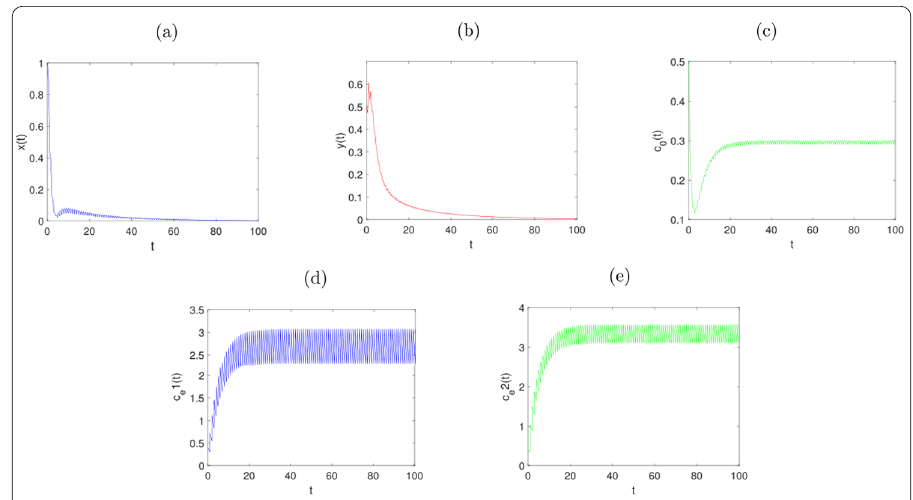
Figure 2 Globally asymptotically stable population-extinction periodic solution of system (2.1) with x ( t ) = 1, y ( t ) = 0.5, c o ( t ) = 0.5, c e 1 ( t ) = 0.4, c 1 = 0.1, d 1 = 0.1, β 1 = 0.01, d 2 = 0.3, β 2 = 0.01, f = 0.1, g = 0.4, m = 0.5, h 1 = 0.3, h 2 = 0.15, a = 0.4, b = 1, c 2 = 0.5, d 3 = 0.1, E 1 = 0.3, d 4 = 0.1, E 2 = 0.05, u 1 = 0.01, u 2 = 0.03, d = 0.5, v 1 = 0.4, v 2 = 0.5, l = 0.5, τ = 1; ( a ) time series of x ( t ); ( b ) time series of y ( t ); ( c ) time series of c o ( t ); ( d ) time series of c